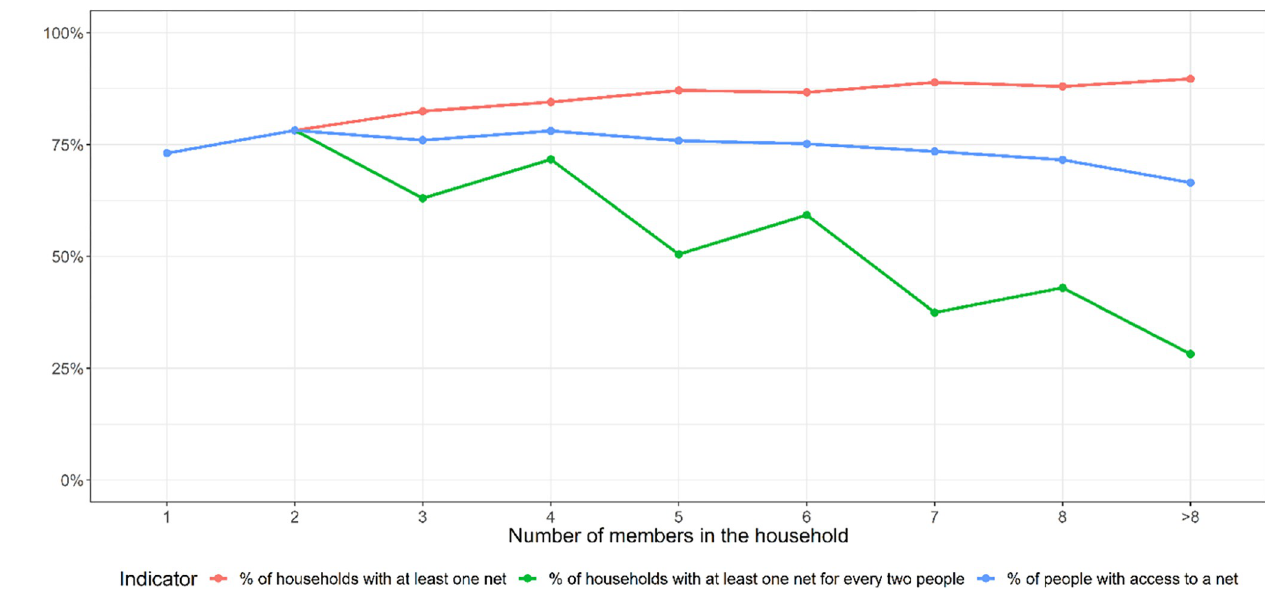
Fig 1. Percentage of households in Magude district with at least one LLIN, of households with a least one LLIN for every two people, and of household members with access to a net, segregated by the size of the